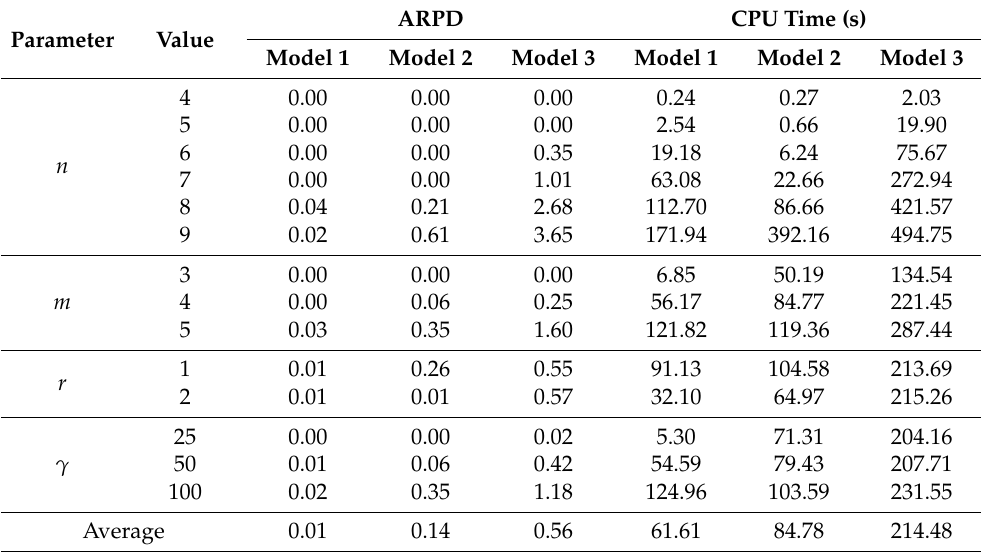
Table 2. Computational results of the proposed MILP models: ARPD values and CPU times (in seconds).